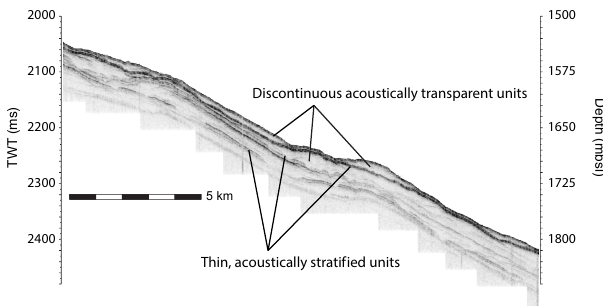
Figure 6. Representative acoustic stratigraphy of the continental slope, where a thin acoustically laminated veneer of sediments over- lies a series of stacked acoustically transparent intervals. Some of the acoustically transparent intervals are laterally continuous but all exhibit substantial downslope variations in thickness. The location of the profile is shown in Fig.